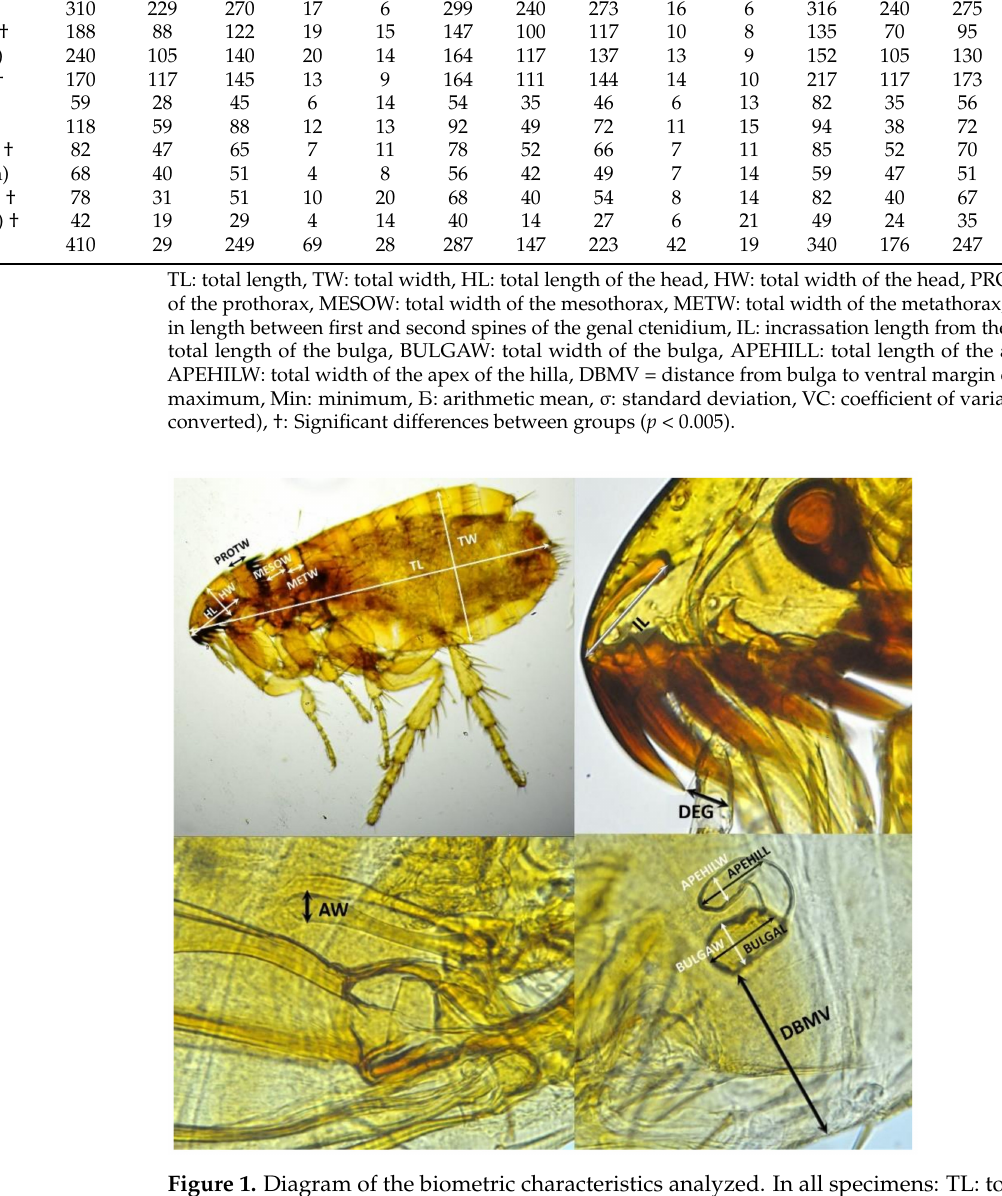
Figure 1. Diagram of the biometric characteristics analyzed. In all specimens: TL: total length, TW: total width, HL: total length of the head, HW: total width of the head, PROTW: total width of the prothorax, MESOW: total width of the mesothorax, METW: total width of the metathorax, DEG: difference in length between first and second spines of the genal ctenidium, IL: incrassation length from the head. In males: AW: Apex width. In females: BULGAL: total length of the bulga, BULGAW: total width of the bulga, APEHILL: total length of the apex of the hilla, APEHILW: total width of the apex of the hilla, DBMV = distance from bulga to ventral margin of the